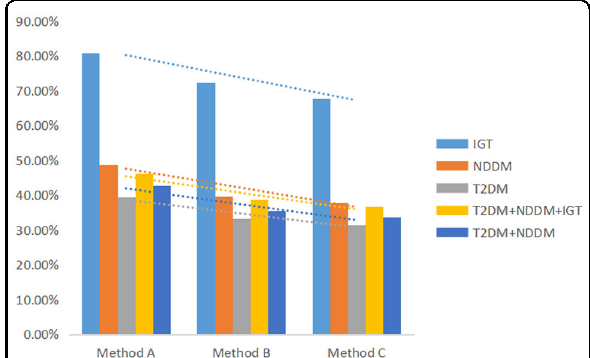
Fig. 3 Relative contribution of PPG to overall hyperglycaemia using three methods in different groups (methods A, B, and C used 6.1 mmol/L, 5.6 mmol/L, and the 24-h glucose pro fi les of the NGT curve as baselines, respectively). Different colors represent different groups.